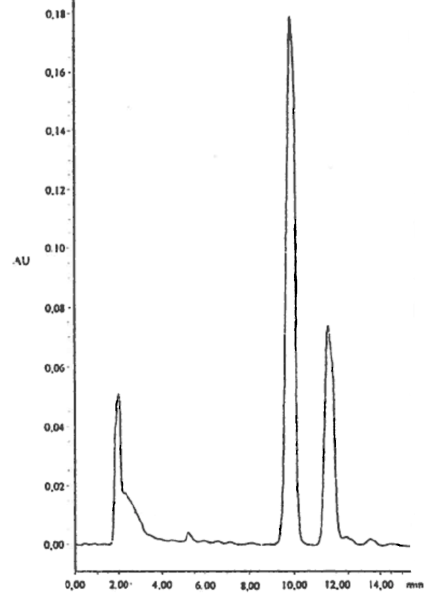
Figure 5. Semipreparative HPLC separation (for conditions, see text) with resolution of the positional isomers 6- O - β - D -glucopyranosyl-feralolide ( 3 ) (t R = 10 min) and 3 ′ - O - β - D -glucopyranosyl-feralolide ( 2 ) (t R = 12 min) relative to their approximately 2.5:1 ratio in the A. vera drug is here reported for the first time.